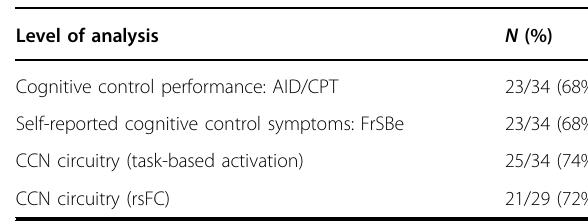
Table 1 Proportion of participants meeting target engagement goal for each level of analysis of